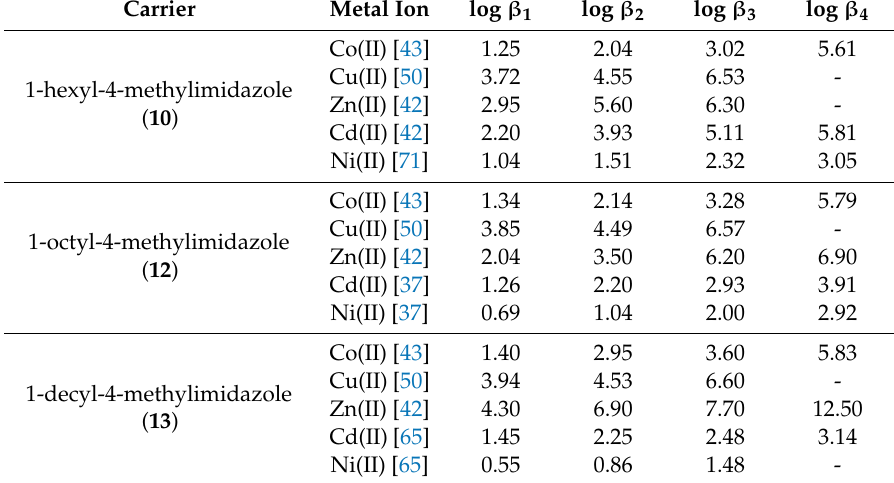
Table 4. The stability constants (log β n ) of Co(II), Cu(II), Zn(II), Cd(II), and Ni(II) complexes